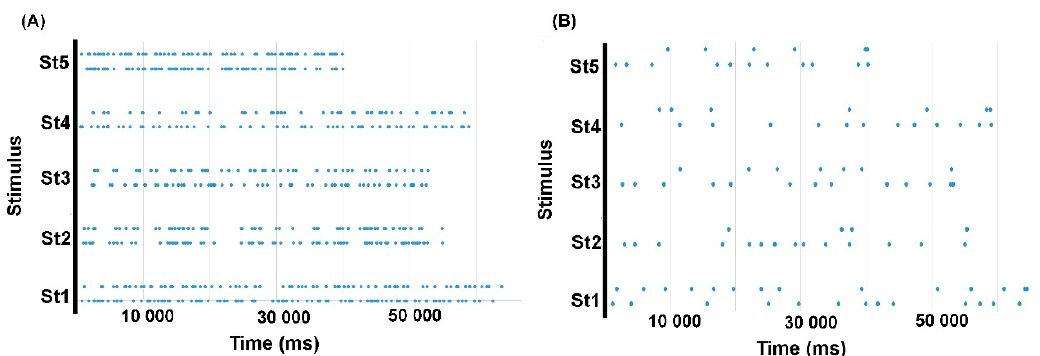
Figure 1. (A) Stimulus-specific global arrays, combining all segmentation models for each utterance (St1-5: Stimulus 1–5; lower line: delexicalized; upper line: natural). Dots represent virtual segmentation points; (B) Example of a segmentation maps (Participant 01) containing actual segmentation marks for each of the five stimuli in natural speech versions (above) and delexicalized ones (below, speech prosody instruction in this case).